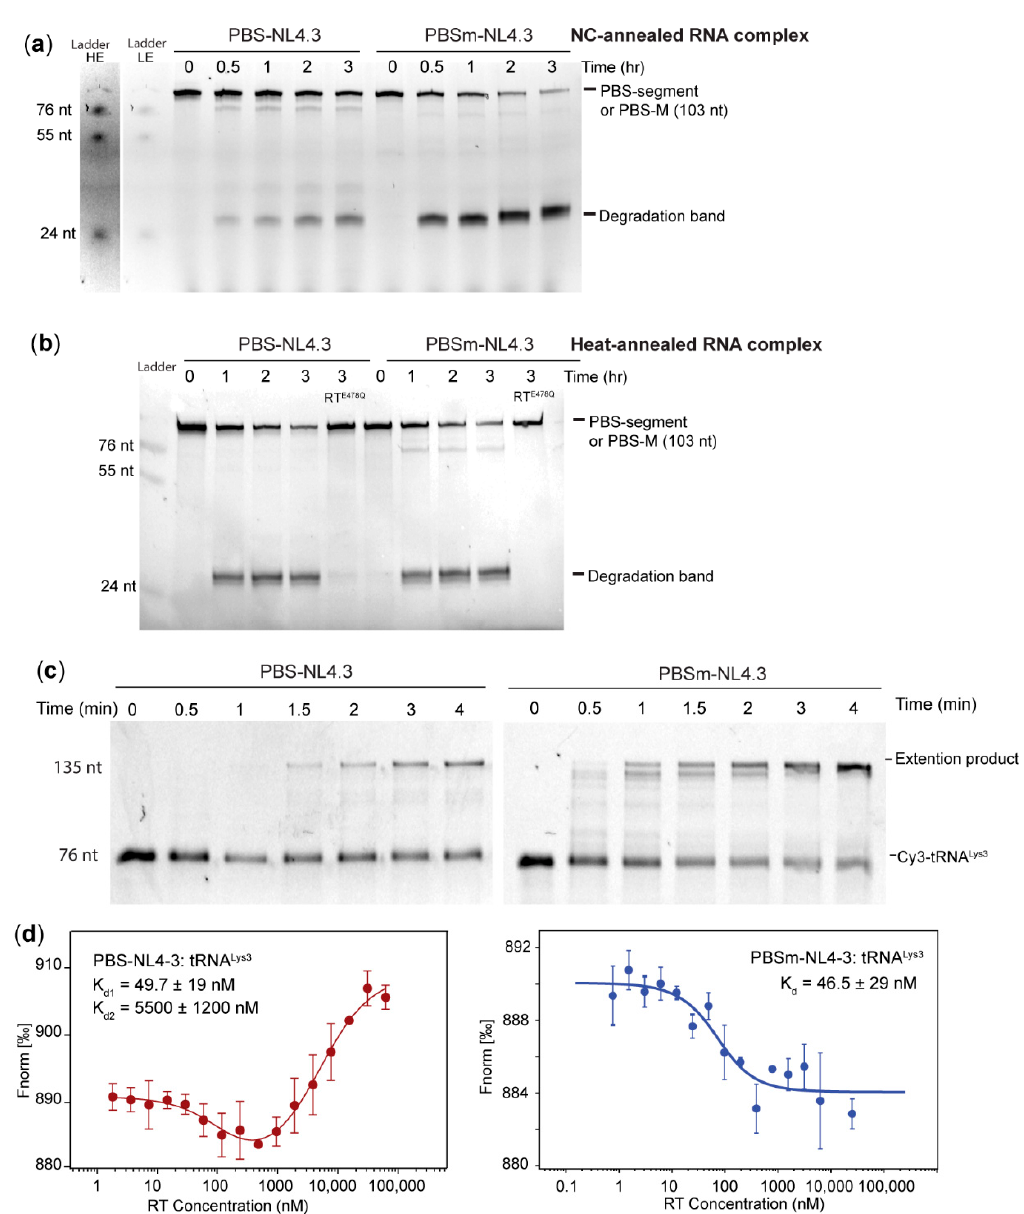
Figure 7. The A-rich loop: anticodon interaction is conserved in HIV-1 NL4.3 to protect the vRNA integrity. ( a ) The PBSm-NL4.3 RNA in the NC-annealed complex was degraded faster the WT RNA in the NC-annealed complex. Ladders are shown in contrasted adjusted levels (left panel, HE = high exposure and LE = low exposure). ( b ) The PBSm-NL4.3 RNA in the heat-annealed complex was degraded at a similar rate as the WT RNA in the heat-annealed complex. ( c ) Primer extension on the mutant PBSm-NL4.3: tRNA Lys3 complex was more efficient than on the WT complex. ( d ) MST binding curves of PBS-NL4.3: tRNA Lys3 (left panel) and PBSm-NL4.3: tRNA Lys3 (right panel) titrated with RT. Representative curve of three experiments is shown; average ± standard deviation.